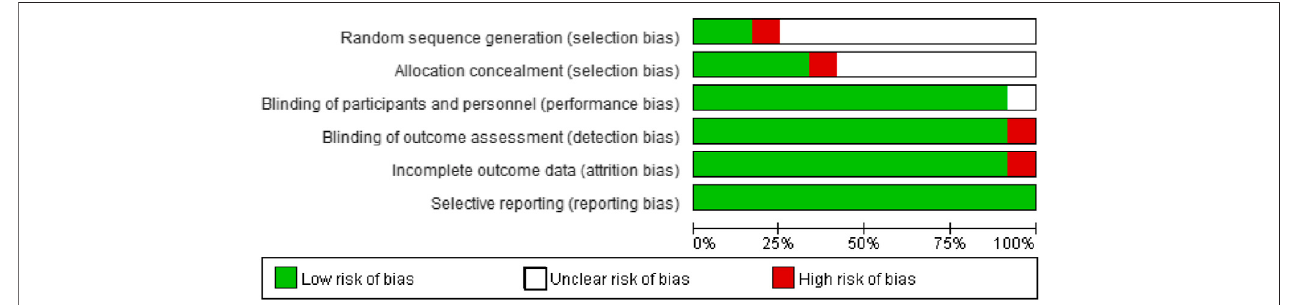
FIGURE 2 | Risk of bias graph.